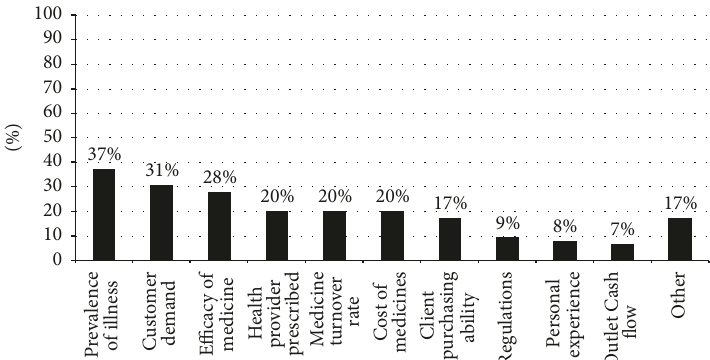
Figure 3: Factors influencing participating vendors’ decisions about what types of medicines to stock. Drug vendors provided multiple responses.